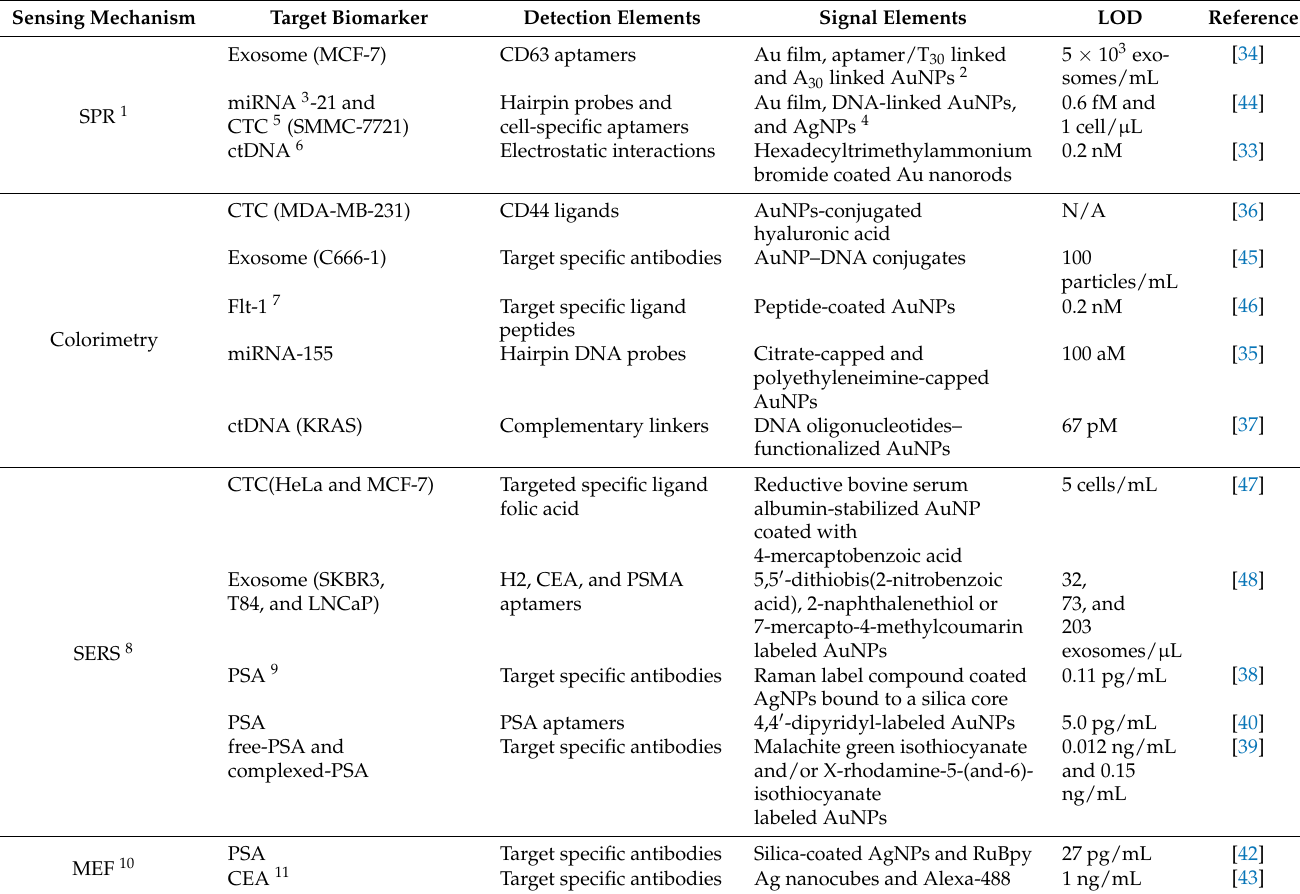
Table 2. Metal nanoparticle-based optical biosensors for circulating cancer biomarkers. Sensing Mechanism